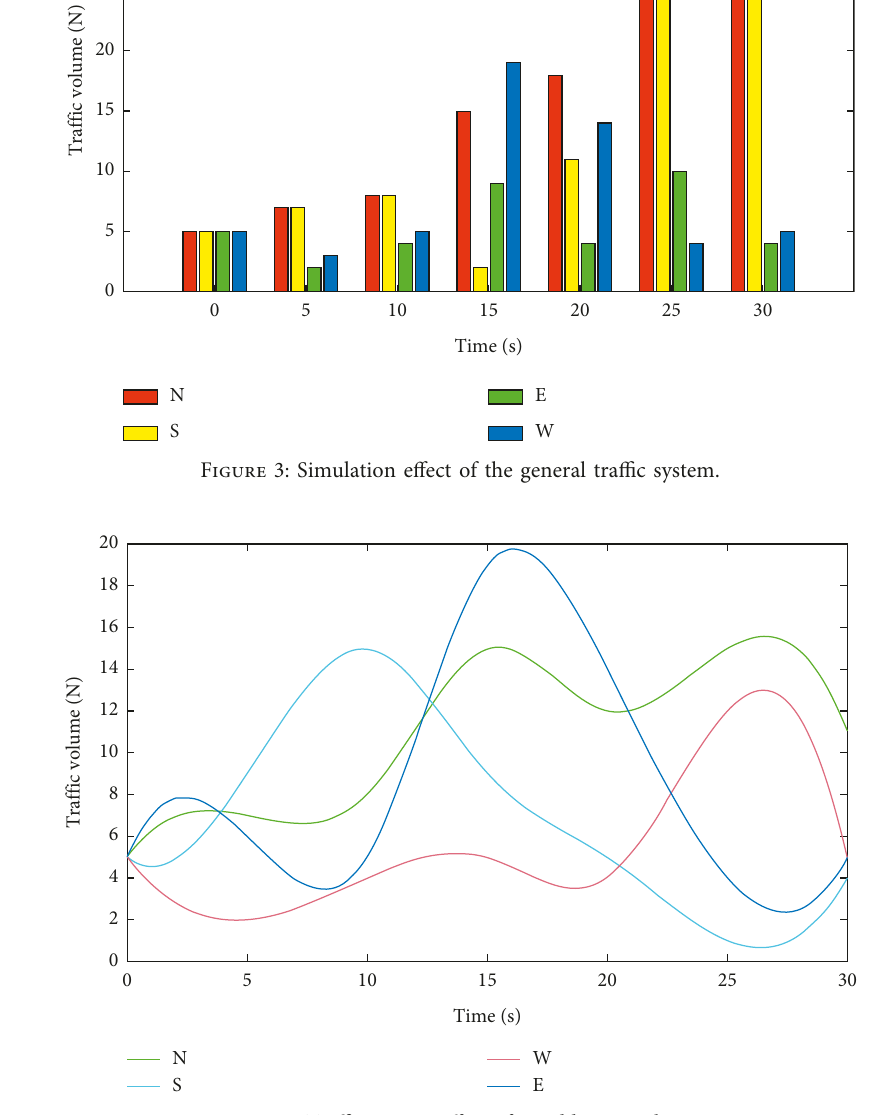
Figure 4: Traffic system effect after adding